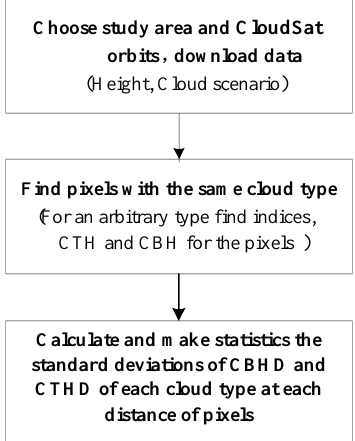
Figure 3. Flowchart of the statistical analysis process. CTH—cloud top height; CTHD—CTH differences; CBH—cloud base height; CBHD—CBH differences.